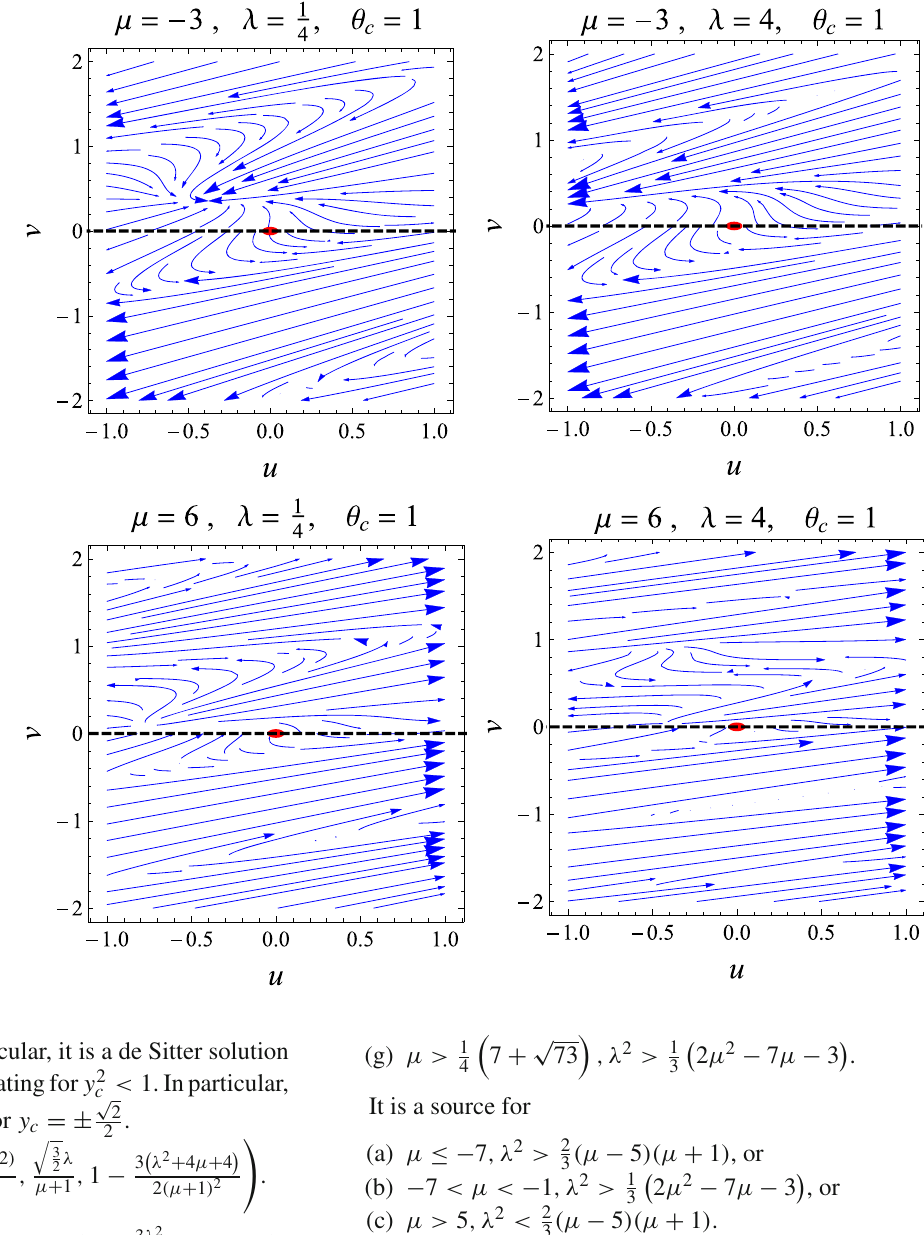
Fig. 11 Phase portrait of (65) for different values of λ,μ ad θ